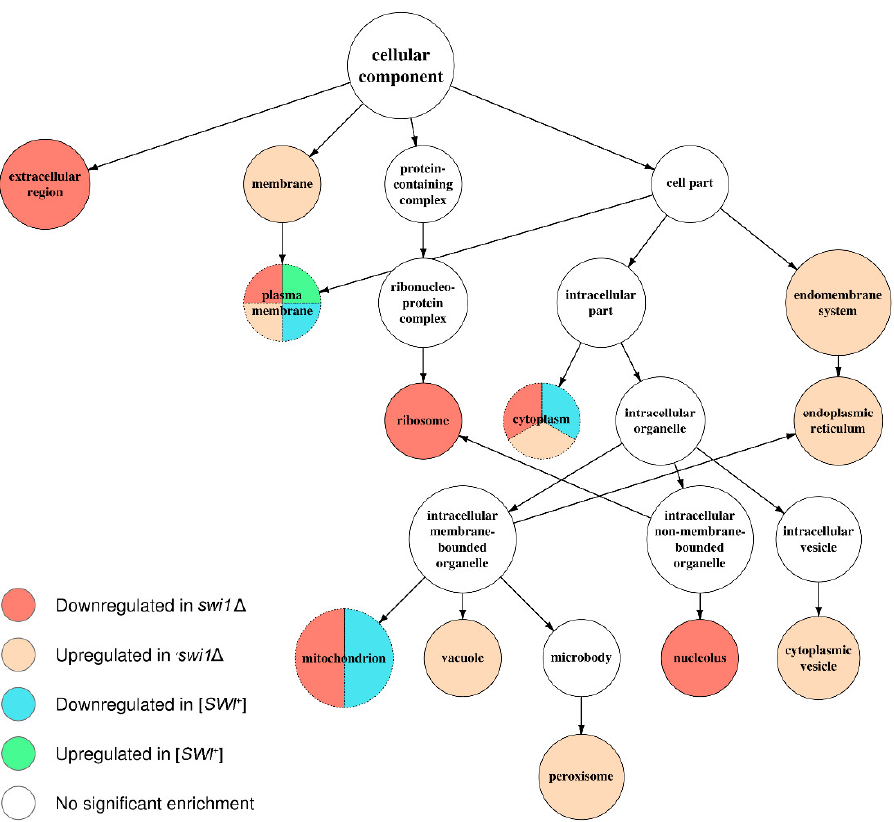
Figure 5. Graph of over-represented terms from Cellular Component (CC) Gene Ontology. Several internal nodes and reticular edges were deleted to improve representativeness. For a full resolution image, see Figure S2 .